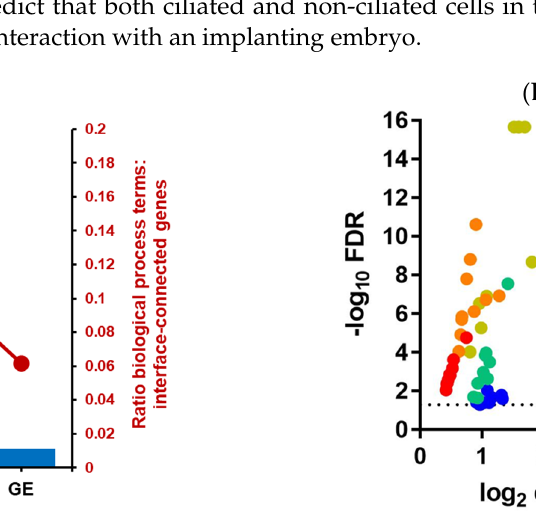
Figure 9. Maternal gene networks at the TE interface elucidated from bulk EEC and single cell (LE, CE and GE) transcriptomes. ( A ) Comparison of hypernetwork (HN) cluster size and enrichment of biological process terms in connections downstream of the maternal-embryo interface between the transcriptomes. ( B ) Summary plot of significance and enrichment levels of overarching biological process terms identified downstream of maternal-embryo interface genes (dotted line represents FDR cut off of 0.05).